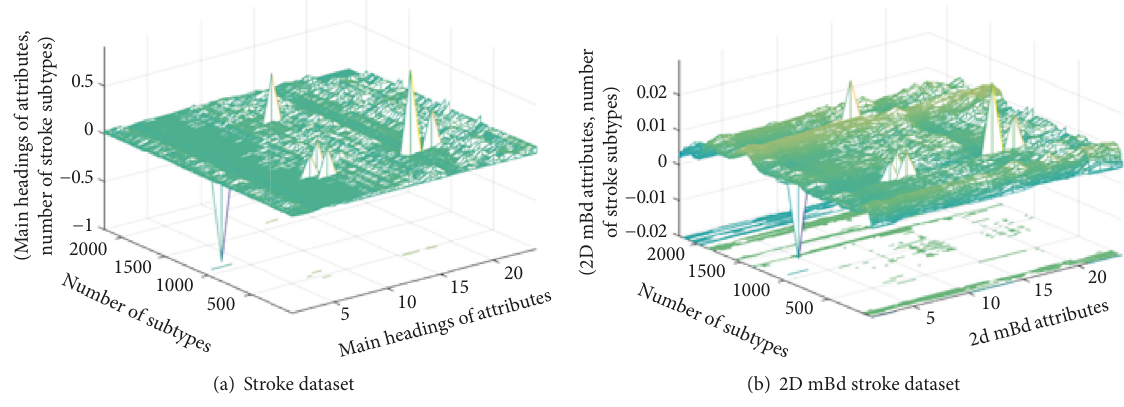
Figure 2: Display of stroke dataset and 2D mBd stroke dataset with mesh plot.